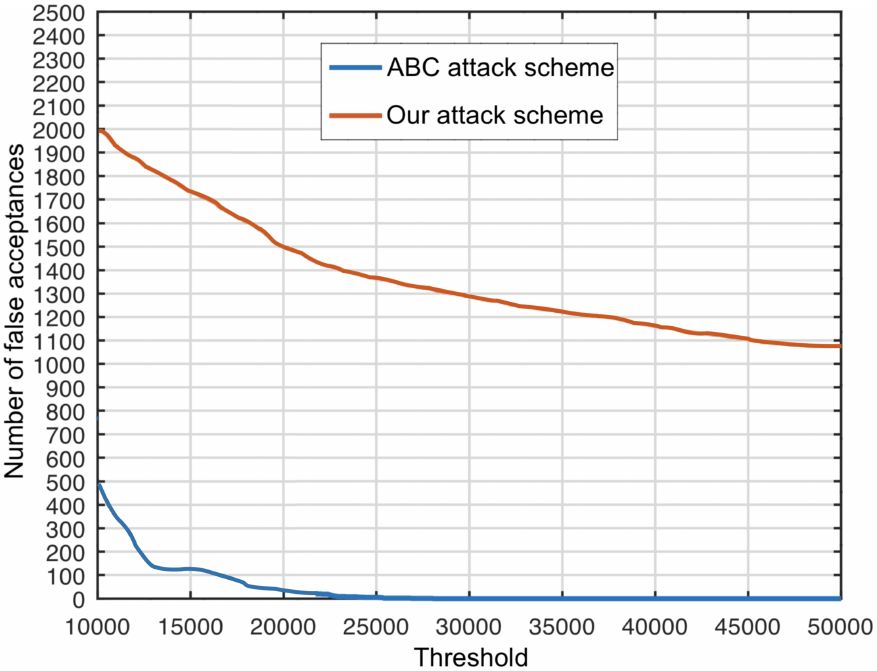
Figure 3. Number of false acceptances (on the vertical axis) bypassing both Forgery Detection and Removal Detection systems of the original ABC protocol, for the attack scheme proposed in [13] versus the attack scheme proposed in [6], when one image is used for PRNU estimation. False acceptances are counted for multiple PCE thresholds (on the horizontal axis) between 10,000 and 50,000, with a step of 100. Best viewed in